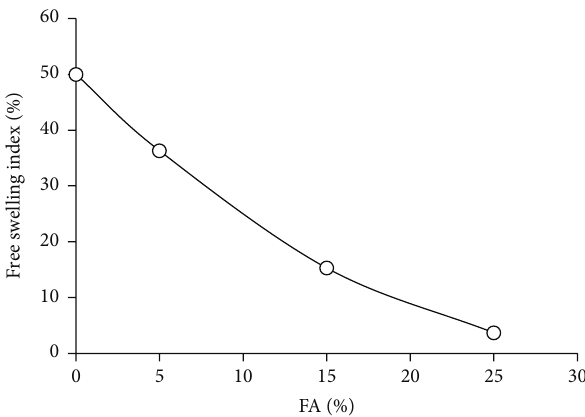
Figure 14: Free swelling index versus the amount of FA content.